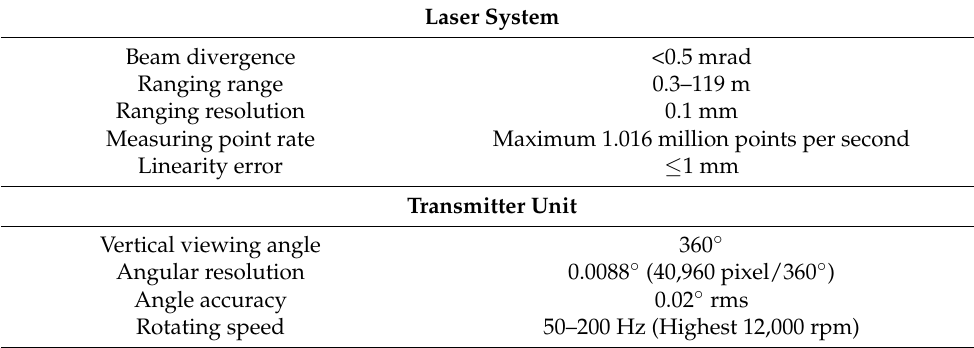
Table 2. Z+F 9012 laser scanner